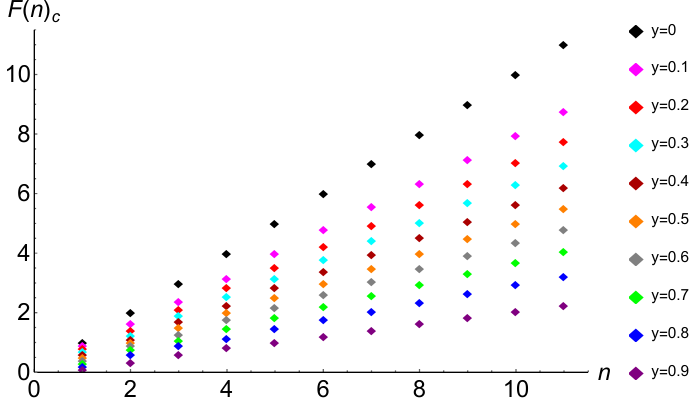
Figure 5: The connected SFF in the ‘t Hooft limit, without unfolding, written in equation (60). As one can see, the resulting SFF is very close to a straight line for any choice of y